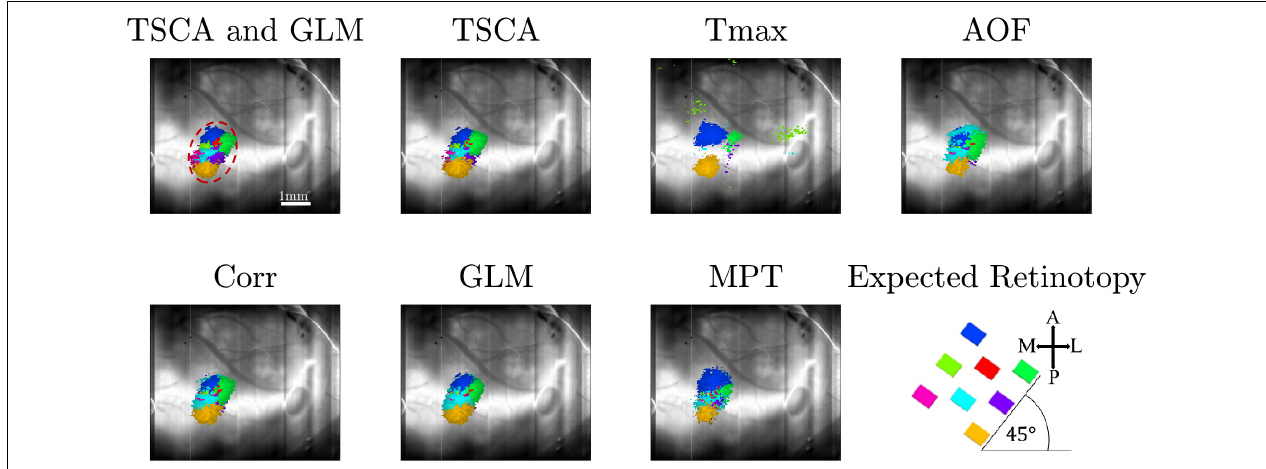
FIGURE 6 | Retinotopic maps generated by the seven methods following a VSDI recording of cortical responses to 8-location grid retinal stimuli. Only pixels with score values above the 90th percentile of all the pixels’ maximum scores are presented. The scale bar shown in the top left panel is 1 mm. The cortical orientations are seen in the bottom right figure, along with the expected cortical response (A, anterior; P, posterior, and M, medial; L, lateral). Each color (hue) represents the cortical response location of the matched retinal stimuli.